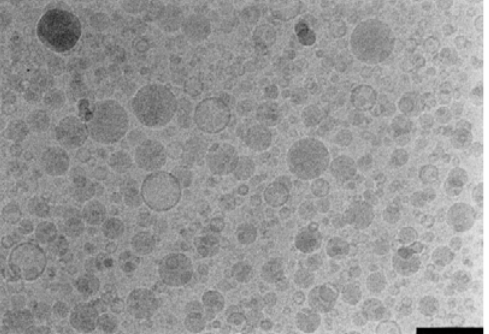
Figure 6. Cryo-EM image of triglyceride oil emulsion showing oil droplets (shaded) and liposomes (clear). Scale bar is 200 nm. Figure taken with permission from reference